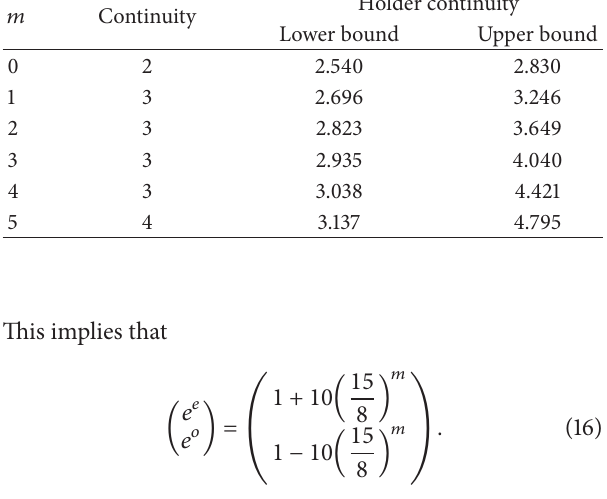
Table 2: Comparison of continuity of the 𝑞 -schemes.